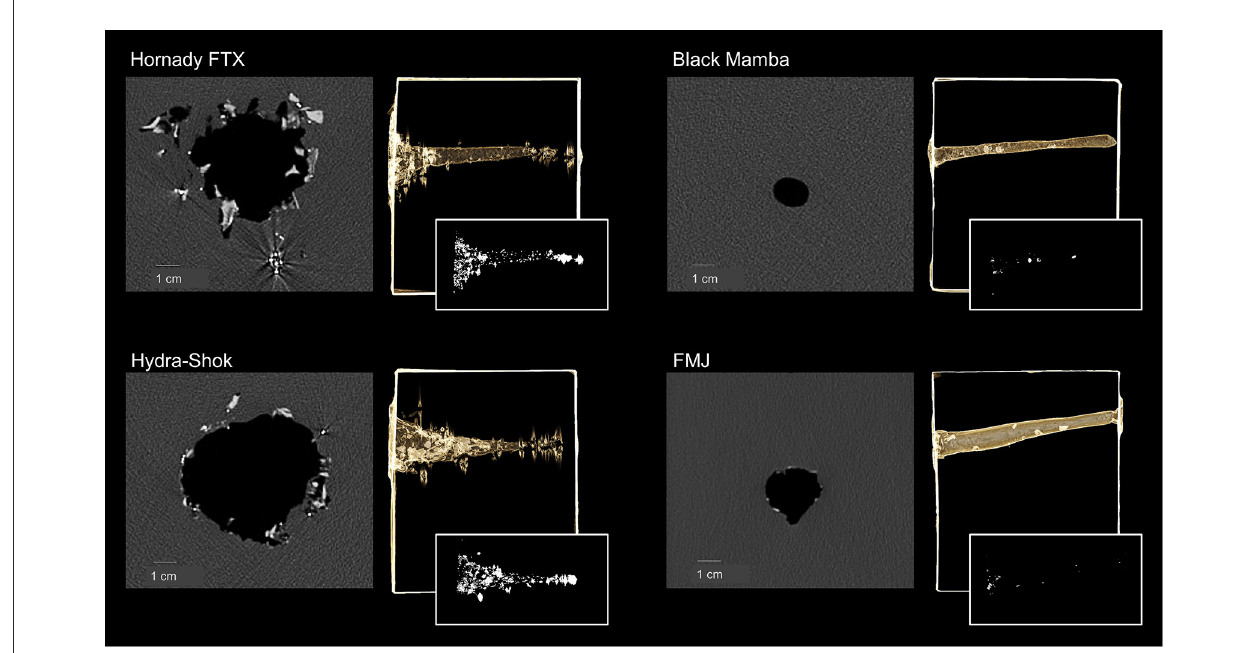
FIGURE3 Transverse cross-sectional CT image through the cavity immediately after the perforation of the frontal bone sample and penetration into the soap block (for each bullet type, the left image in grayscale), volume rendering to show the entire cave in the soap block (for each bullet type, the right image kept in the color of the soap block), and maximum intensity projection to highlight bullet fragments along the cavity (for each bullet type, the right small image in black and white).